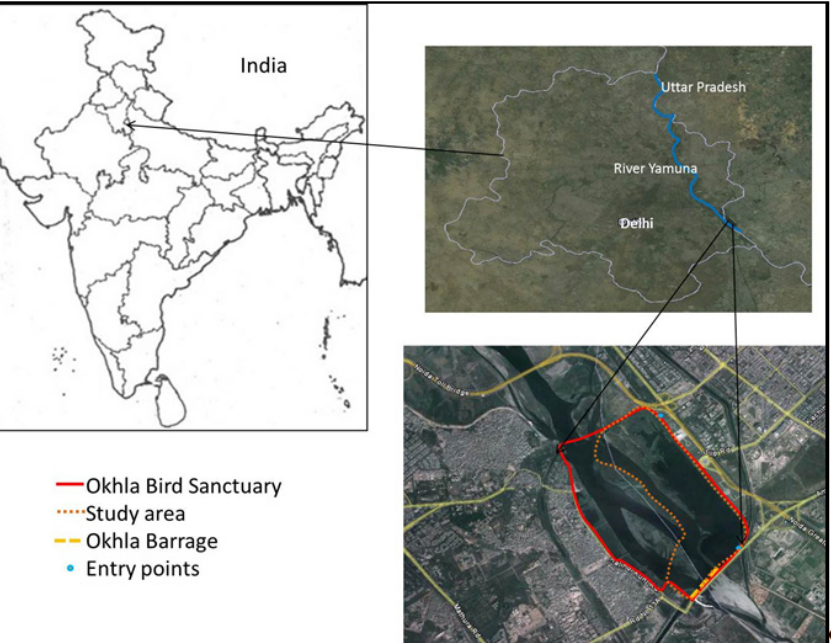
Fig. 1. Map of Okhla Bird Sanctuary, a point where River Yamuna enters the state of Uttar Pradesh from Delhi